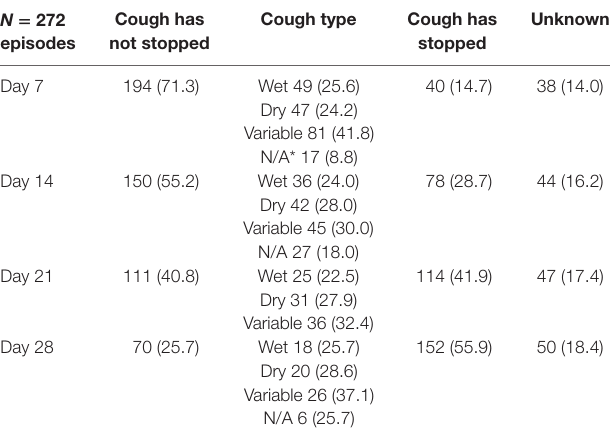
TaBle 3 | Weekly cough persistence a and cough type over 28 days in 272 episodes of